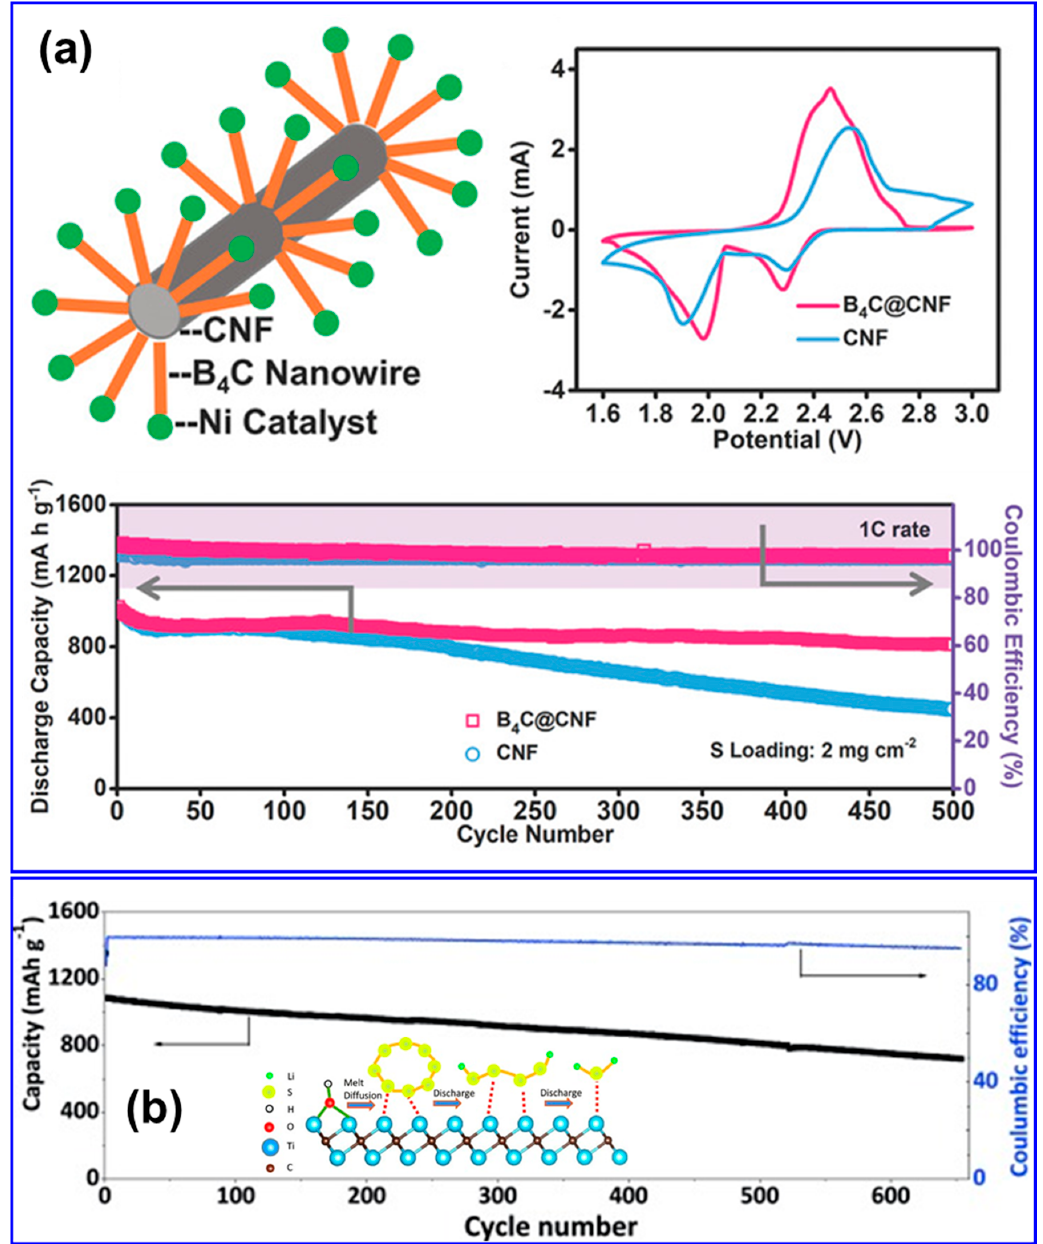
Figure 10. ( a ) Top left: Schematic structure of the B 4 C@CNF electrocatalyst; Top right: CV curves of the electrocatalyst compared with CNF. Bottom: long-term cycling performance of the electrodes. Reproduced with permission, Copyright, 2018, American Chemical Society [101] . ( b ) Long-term cycling performance of Ti 2 C electrodes at C/2 rate, inset shows the representative functioning of Ti 2 C depicting the replacement of the Ti-OH bond of the MXene surface with an S-Ti-C bonding on contact with LiPS. Reproduced with permission, Copyright, 2015, Wiley [113] .